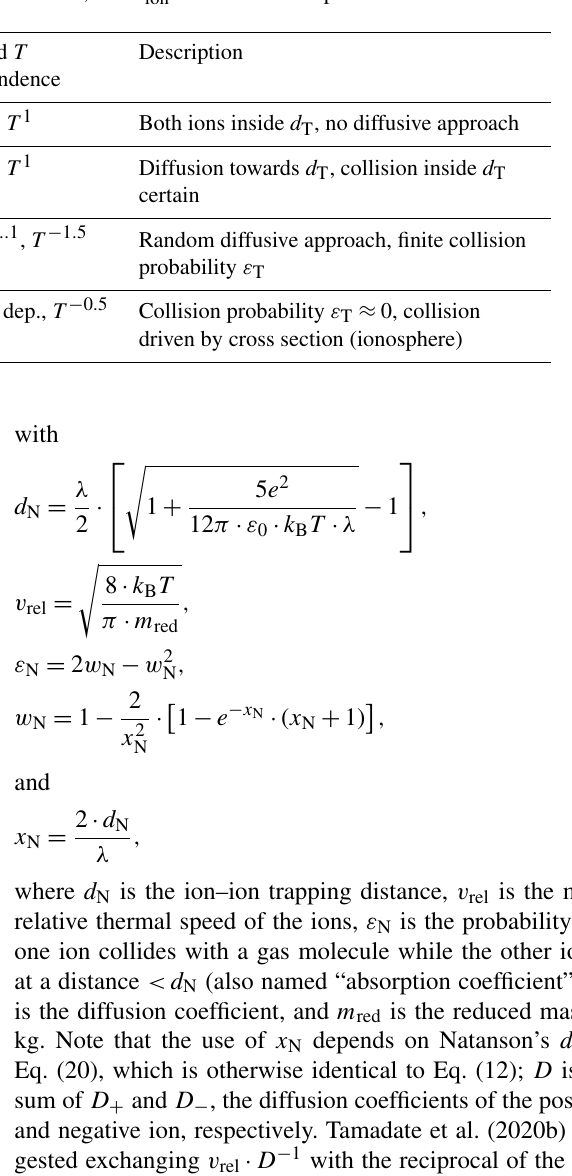
Table 1. Selection of ion–ion recombination theories described in detail by Loeb (1960), where d T is the radius of mutual Coulomb attraction between the two ions of opposite charge, r 0 is the initial distance of the two ions, and λ ion is the mean free path of one